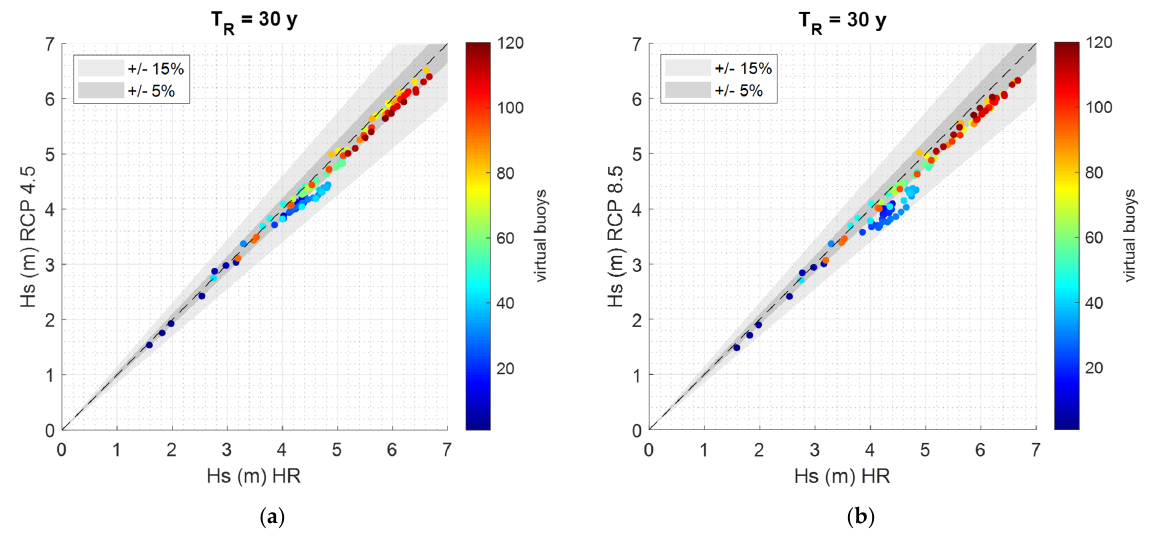
Figure 5. Comparison between the 30-year return period significant wave heights Hs computed at the 120 virtual buoys along the Italian Adriatic coast relative to the historic run (HR) and future scenario runs: ( a ) historic run vs. RCP 4.5 scenario; ( b ) historic run vs. RCP 8.5